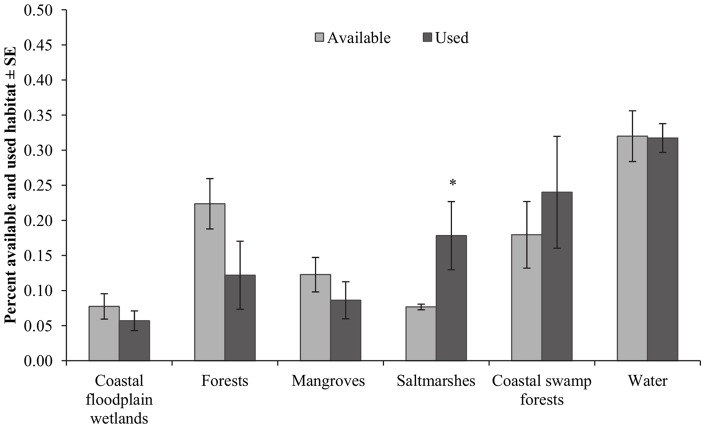
Habitat availability and use in February 2010.Percentage of available and used habitat in February 2010.